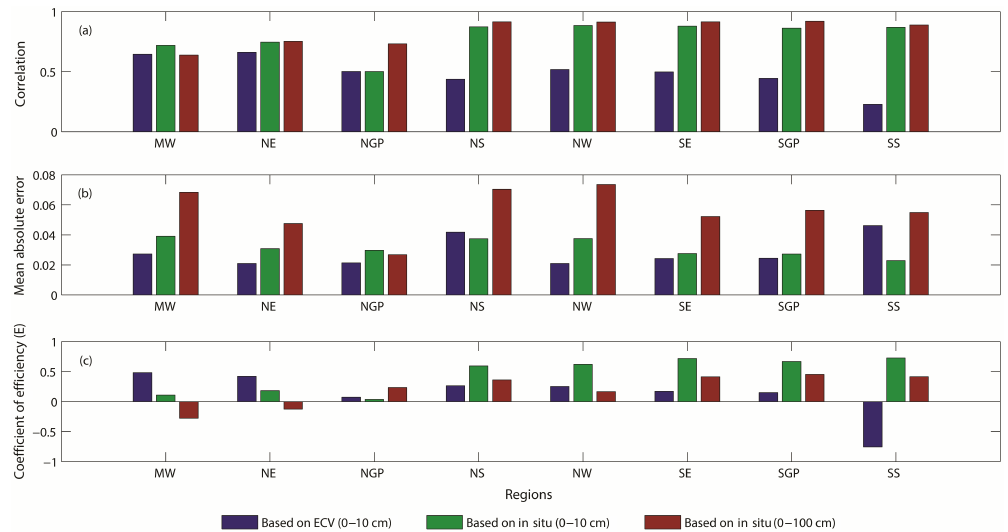
Figure 8. Performance evaluation statistics for CMIP5 ensemble mean versus ECV satellite data and in situ soil moisture (2003–2012): (a) correlation coefficient, (b) mean absolute error and (c) coefficient of efficiency for the eight